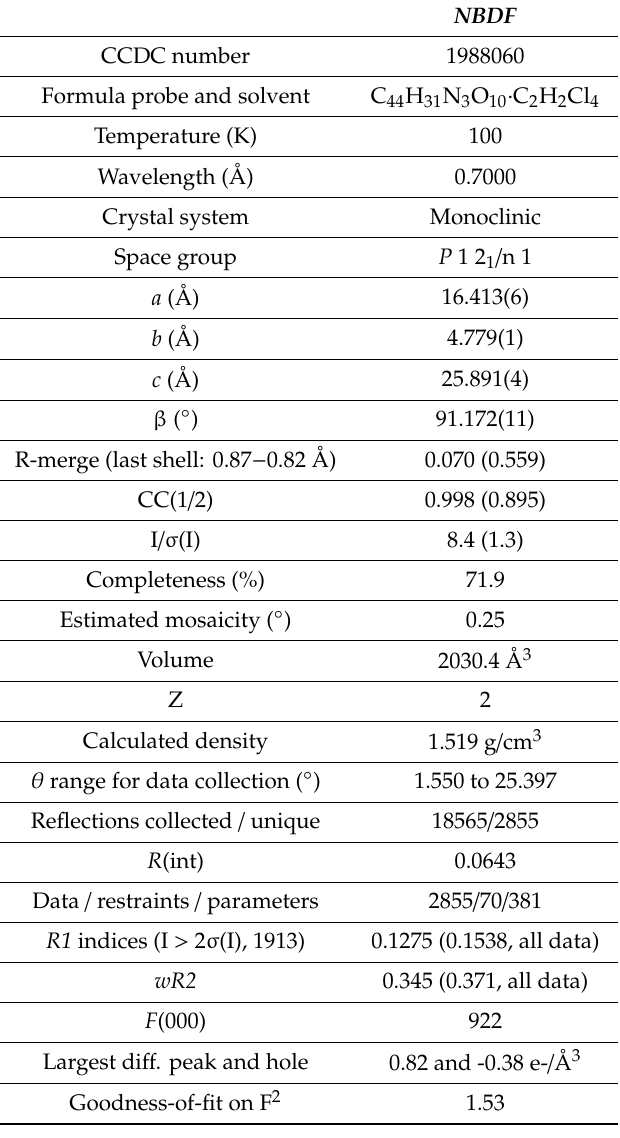
Table 1. Crystal data and structure refinement details for